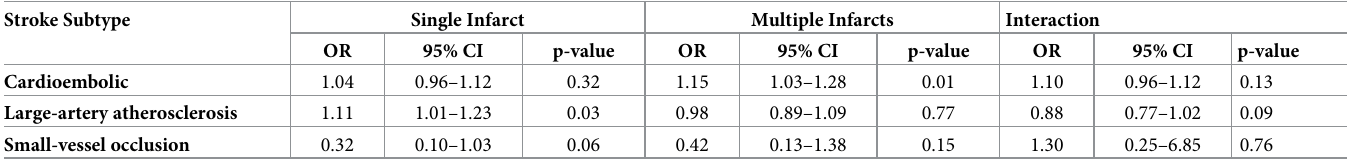
Table 4. Effect measure modification by number of infarcts demonstrating the adjusted odds ratio (OR) of each specified stroke subtype per 5 mL increase in ische- mic stroke infarct volume (N = 150). Stroke